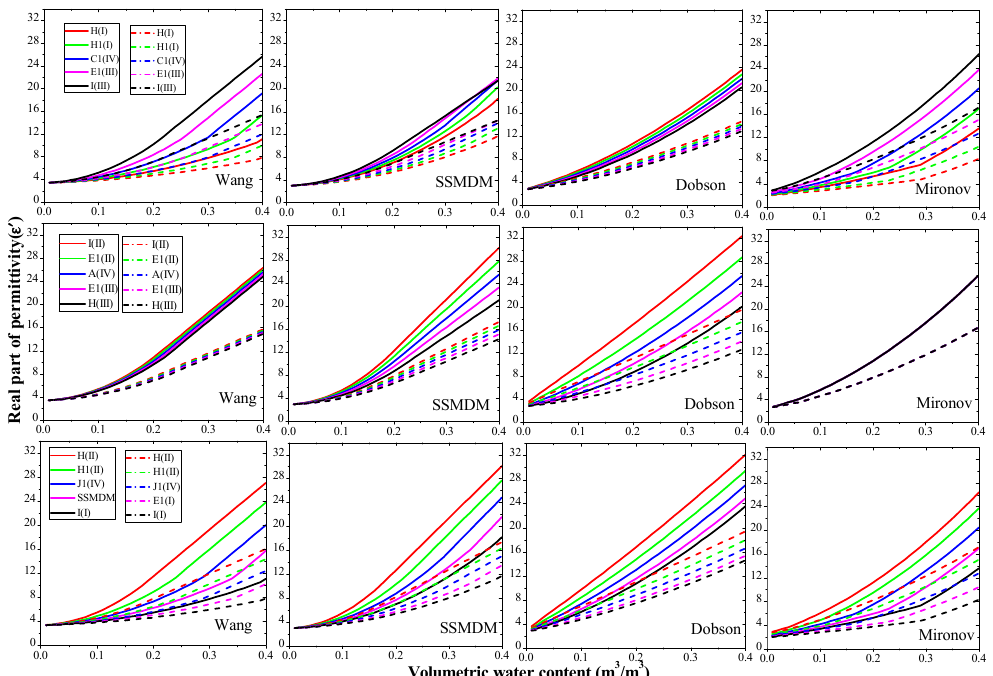
Figure 5. The simulations of the real parts for different soil texture types under the same model. Top